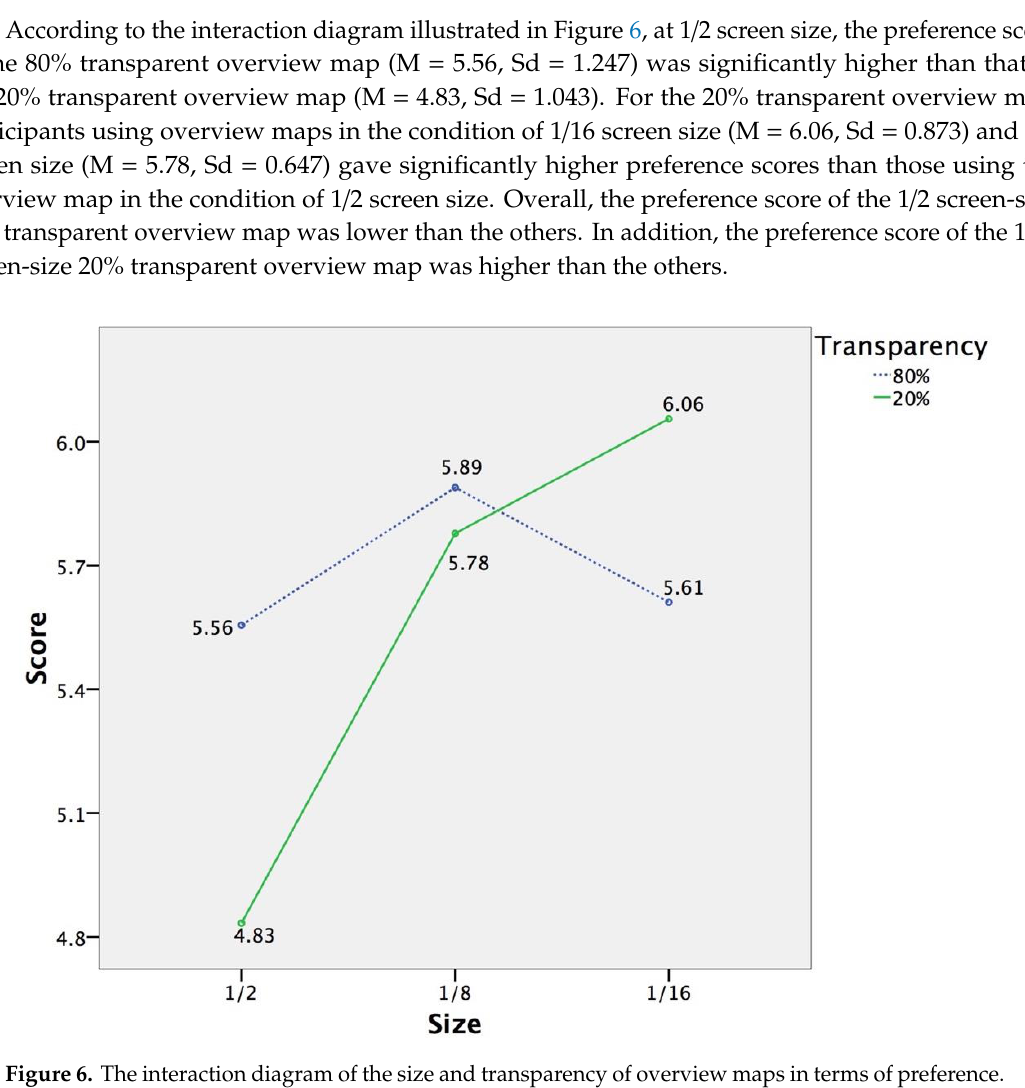
Figure 6. The interaction diagram of the size and transparency of overview maps in terms of preference.